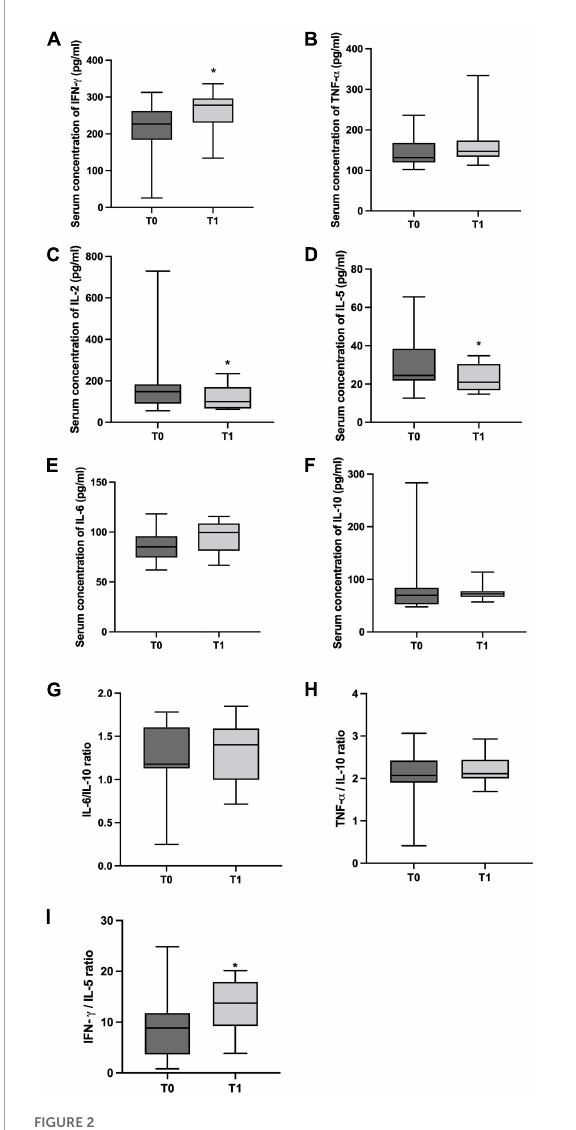
FIGURE2 The boxplots show the median/minimum-maximum values for serum concentration of cytokines (pg/ml). (A) interferon- gamma (IFN- γ , T0: 219.20/25.80-288.40 and T1: 278.00/134.00-336.00), (B) tumor necrosis factor- alpha (TNF- α , T0: 136.00/102.20-236.00 and T1: 146.90/112.90-333.90), (C) Interleukin (IL)-2 (T0: 148.30/55.75-267.00 and T1: 99.75/62.50-234.50), (D) IL-5 (T0: 24.83/21.70-52.86 and T1: 20.93/14.70-34.77), (E) IL-6 (T0: 98.79/70.31-118.20 and T1: 99.58/66.63-115.70), (F) IL-10 (T0: 71.13/47.74-283.40 and T1: 72.3/56.93-113.90) and (G) IL-6/IL-10 (T0: 1.32/0.25-1.78 and T1: 1.40/0.71-1.85), (H) TNF- α /IL-10 (T0: 2.14/0.41-3.07 and T1: 2.11/1.69-2.93), (I) IFN- γ /IL-5 (T0: 8.63/0.81-12.33 and T1: 13.75/3.85-20.14) ratios before (T0) and after 6 months of physical distancing (T1). * differences between groups (Wilcoxon test, p <